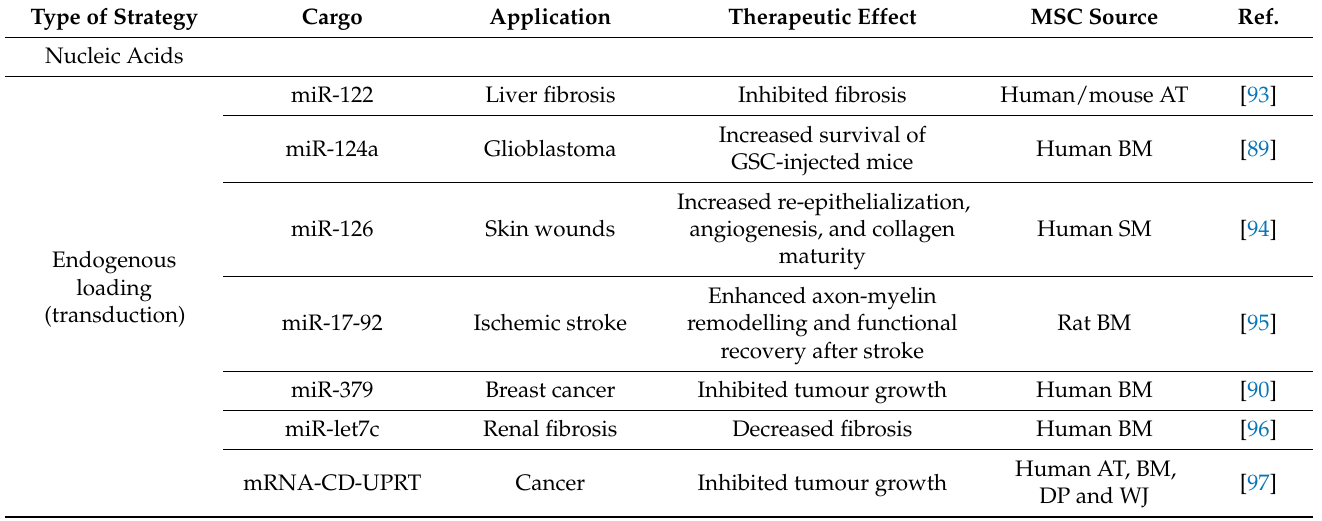
Table 1. Overview of the potential strategies and applications of cargo-engineered mesenchymal- stromal-cell-derived extracellular vesicles